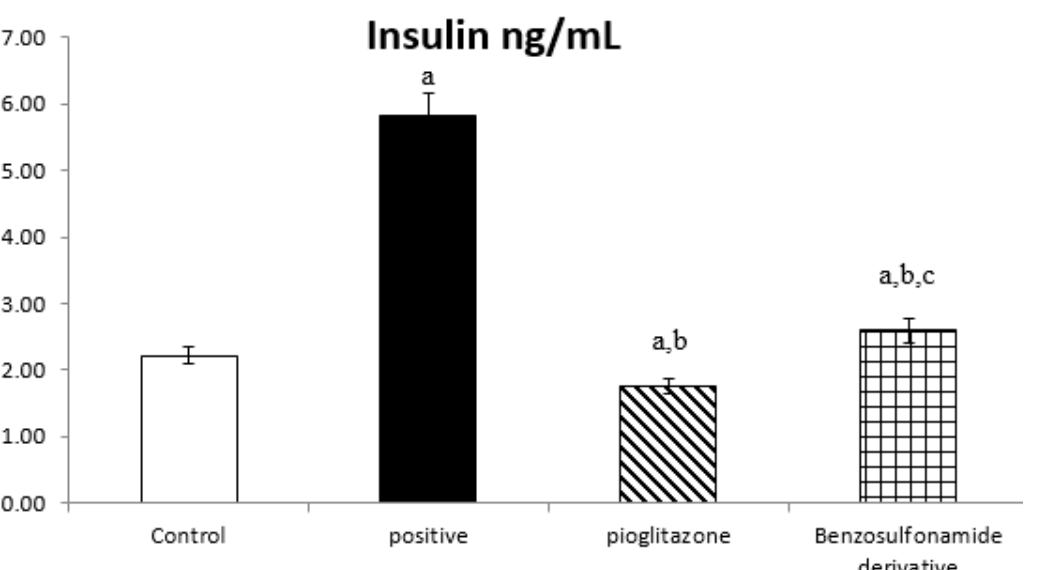
Figure 1. Bar chart presentation of fasting serum insulin concerning the effect of 14 days of oral administration of the synthetic compound against the reference anti-hyperglycemic pioglitazone on STZ-induced type 2 DM. DM: diabetes mellitus. Each bar represents the mean of 6–8 values ± the standard error of the mean (S.E.M). a: Significantly different from the normal control group, b: Sig- nificantly different from the positive control group, c: Significantly different from the pioglitazone group at p <